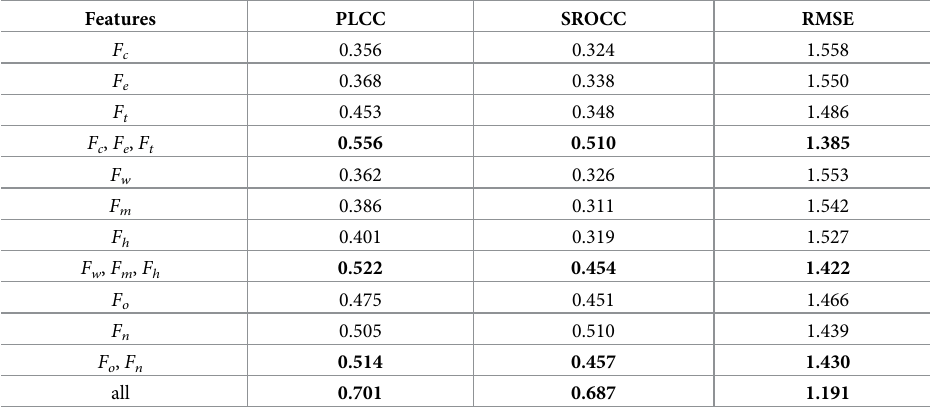
Table 3. Performance comparison of different feature